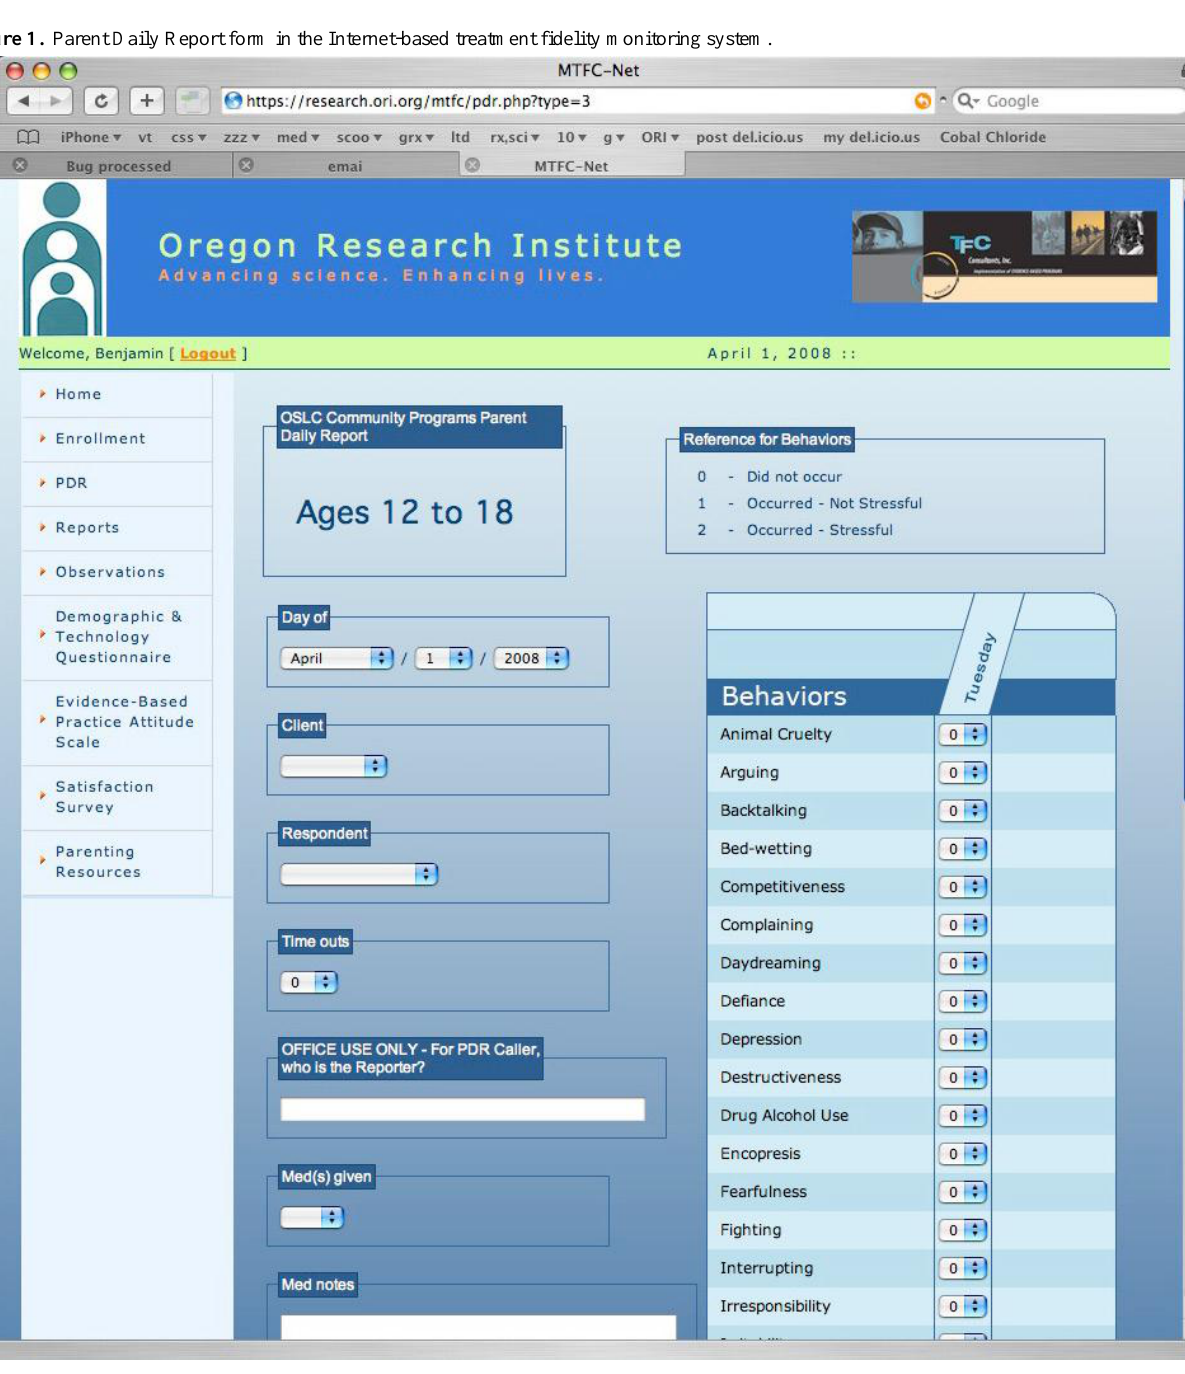
Figure 1. Parent Daily Report form in the Internet-based treatment fidelity monitoring